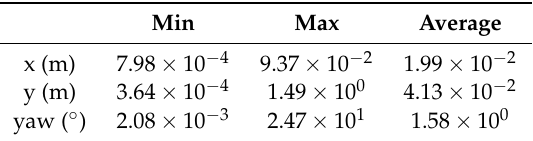
Table 3. Discrepancy prior to the compensation (per unit